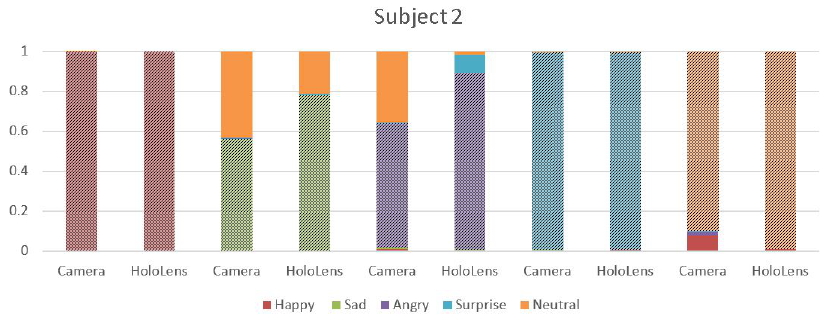
Figure 5. Comparison of average emotion recognition accuracy for the five emotions for Subject 2 using MHL and webcam.